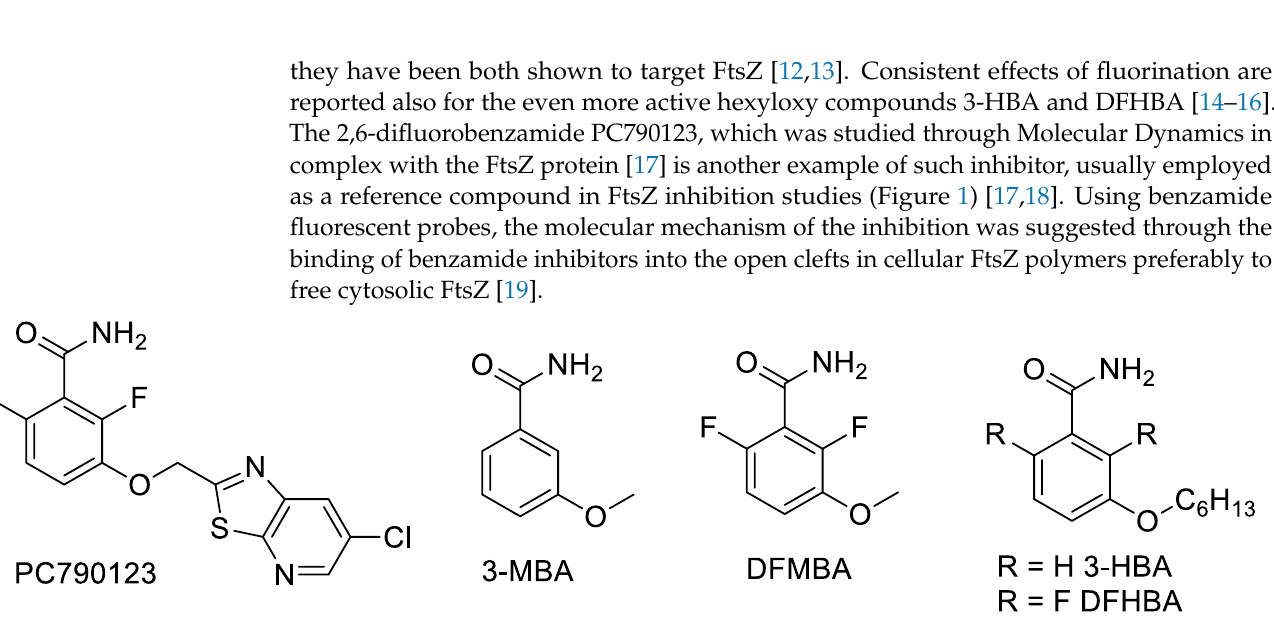
Figure 1. Structure of benzamide FtsZ inhibitors: PC190723, 3-MBA, DFMBA, 3-HBA and DFHBA.